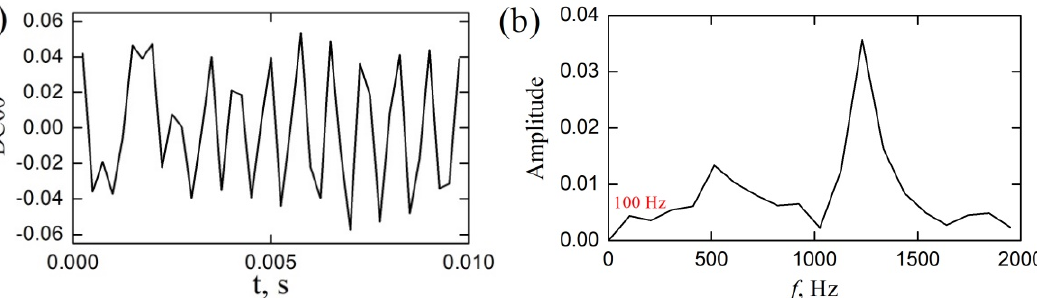
Figure 13. ( a ) The unsteady fluctuation and ( b ) the spectrum of the total pressure distortion at the AIP.